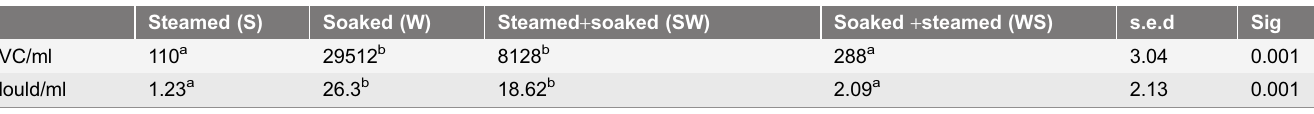
Table 5. Geometric mean numbers (CFU/ml) of bacteria (TVC) and mould in the effluent after soaking, steaming and a combination of both applied to five different UK hays. Steamed (S) Soaked